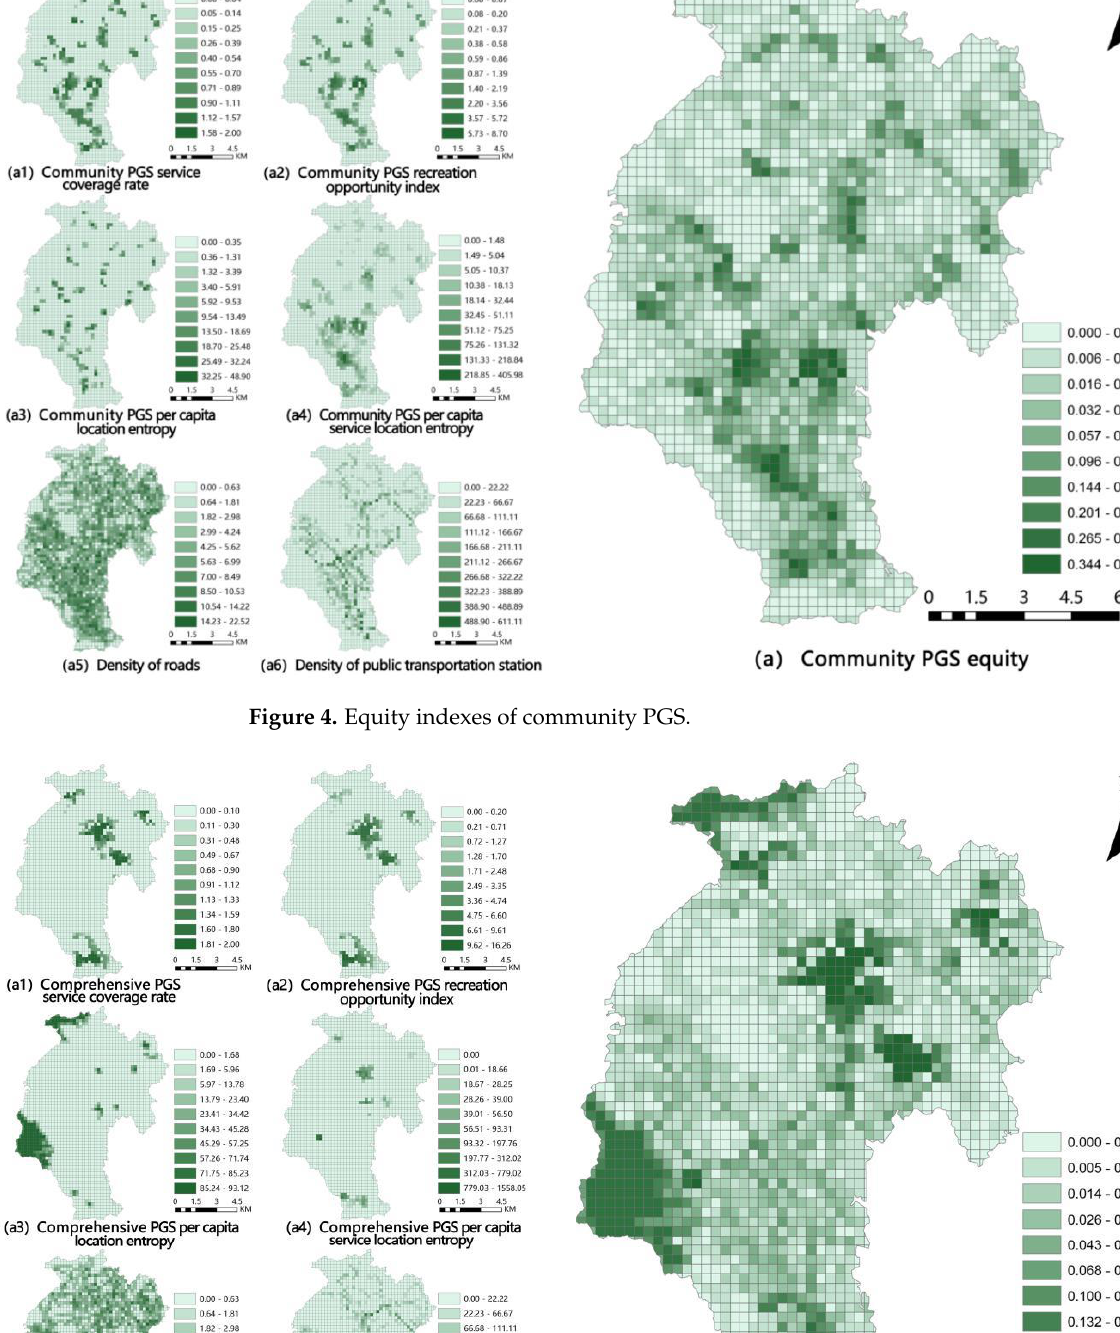
Figure 3. Equity indexes of pocket PGS.